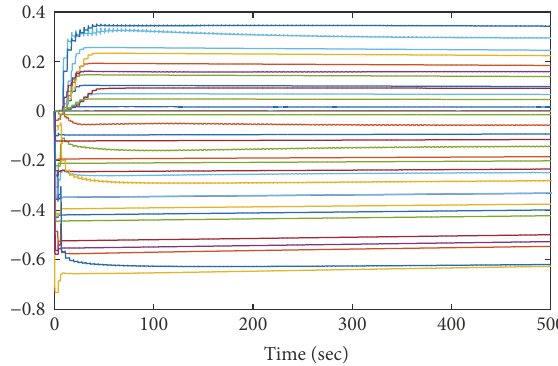
̂𝑊 these parameters in (3) are chosen as 𝛽 0 = 1 , 𝛽 ∞ = 0.05 , 2 . 𝜅 = 2 𝛽 󸀠 = 0.05 , 𝜅 󸀠 = 1 , and 𝛿 󸀠 ∞